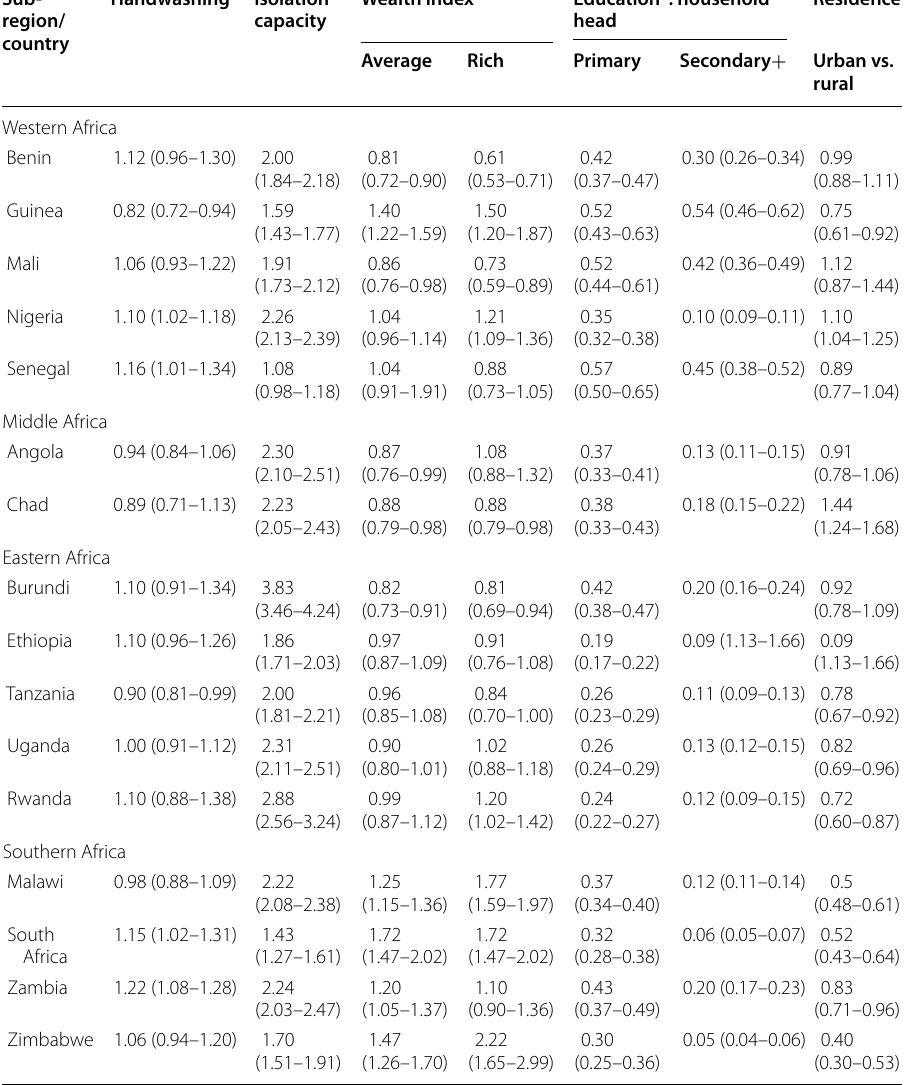
Table 6 Adjusted Odds Ratio (OR) for association between background characteristics and household presence of older persons in selected African